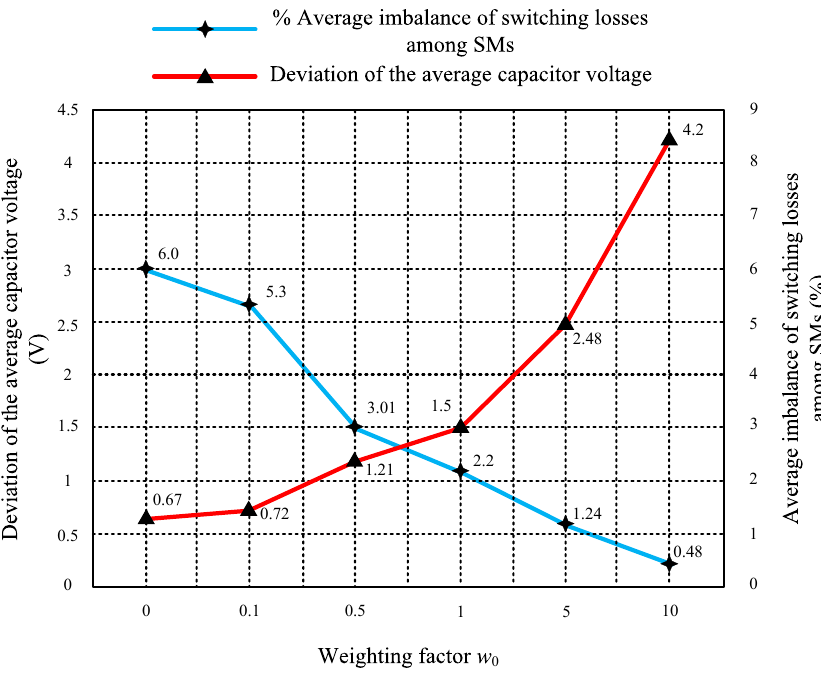
Figure A2. Deviation of the average capacitor voltages and average imbalance of switching losses among SMs versus varying w 0 .